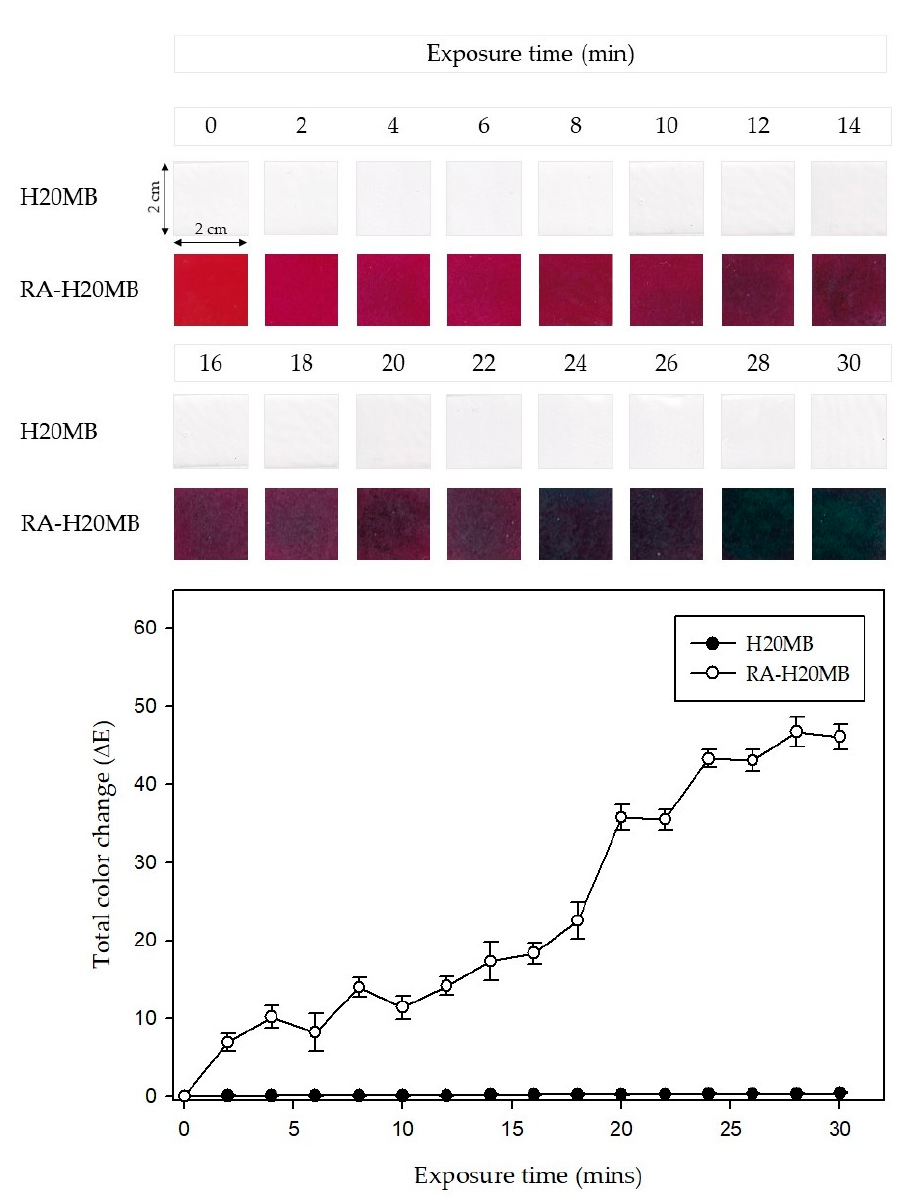
∆ E) of the RA-H20MB indicators upon exposure to NH Figure 6. Total color change ( Δ E) of the RA-H20MB indicators upon exposure to NH 3 vapors. Figure 6. Total color change ( The color change and ∆ E values of RA-H20MB indicator are presented in Figure